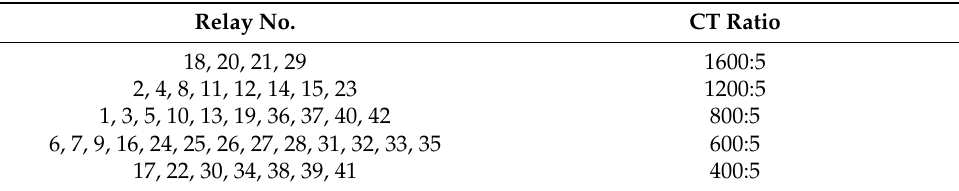
Table 6. Current transformer ratio.